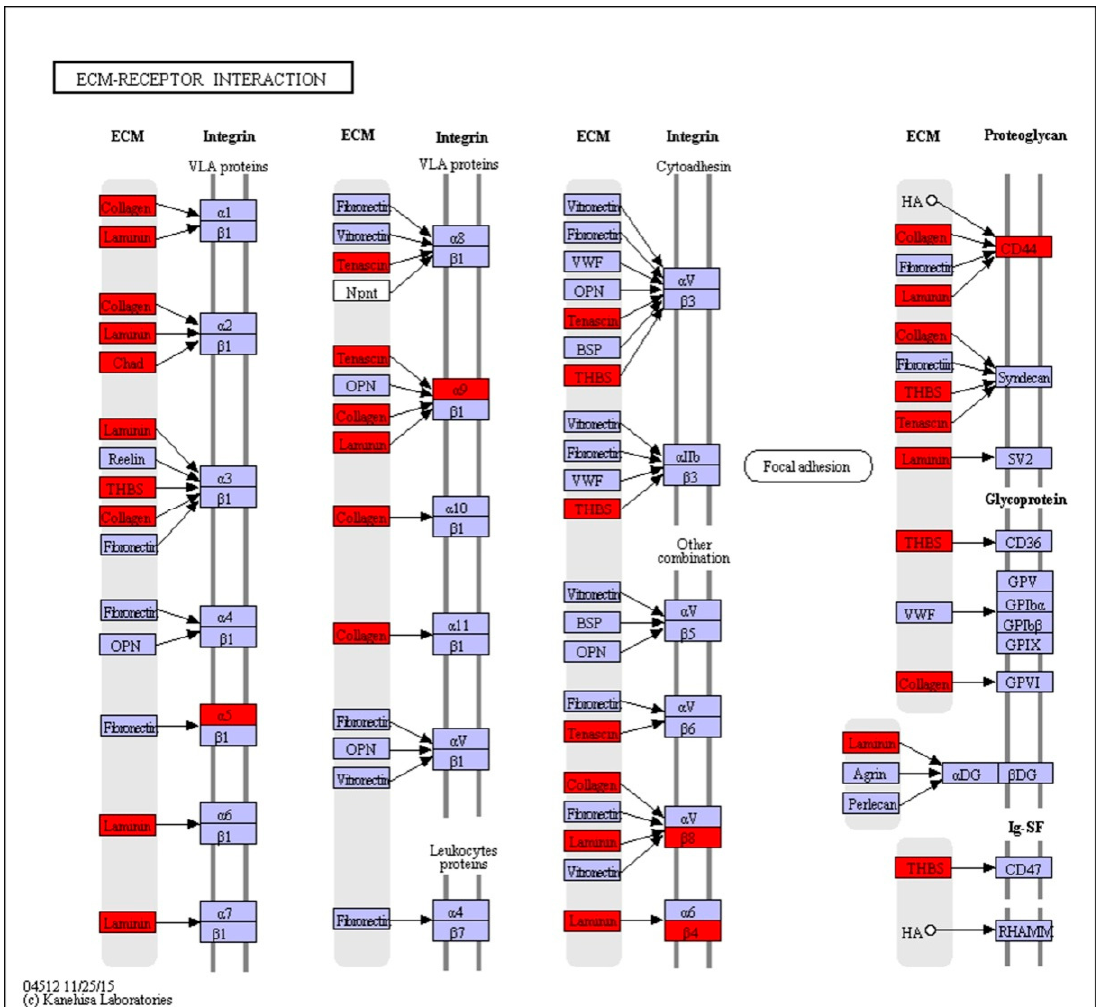
Figure 2. Model of activation of the extracellular matrix (ECM)-Receptor interaction pathway in the mink uterus in activated versus diapause states. Differentially expressed genes are shown in red color. Genes in blue boxes were present in the mink transcriptome but not differentially expressed.